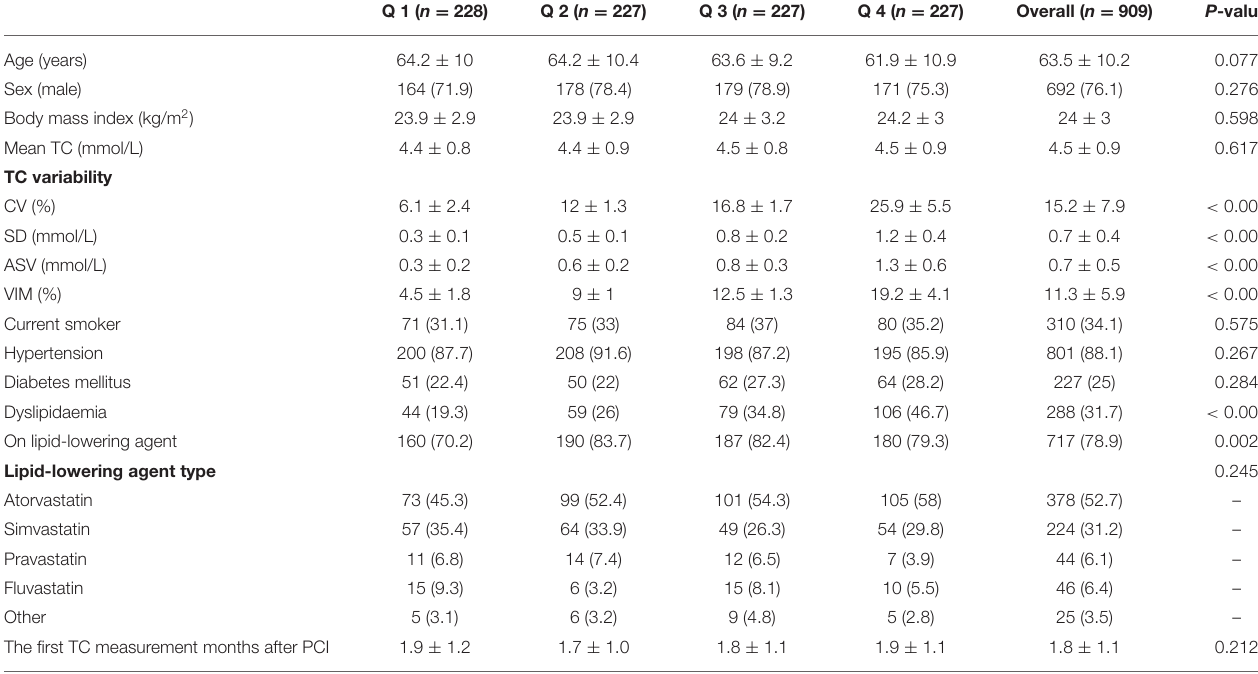
TABLE 1 | Baseline characteristics of subjects to the total cholesterol variability (coefficient of